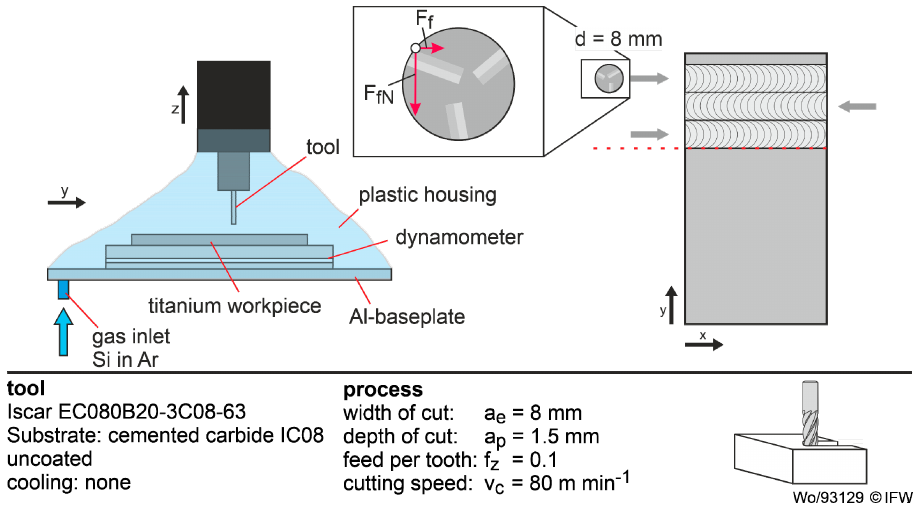
Figure 2. Setup of the dry milling experiments.